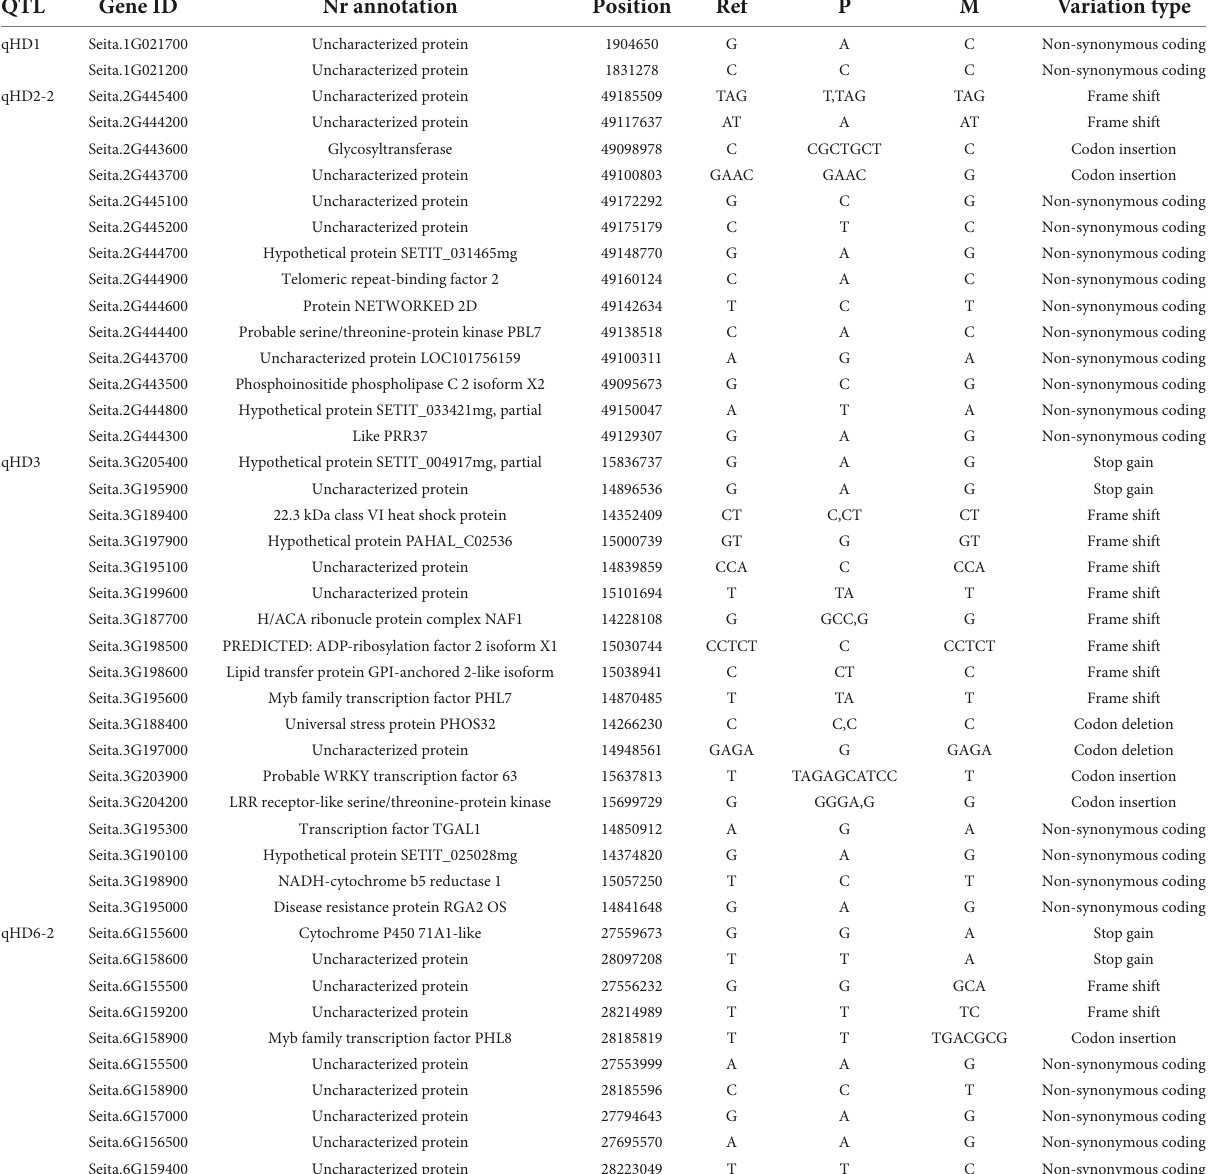
TABLE 4 Variation analysis between parents of the candidate genes in major